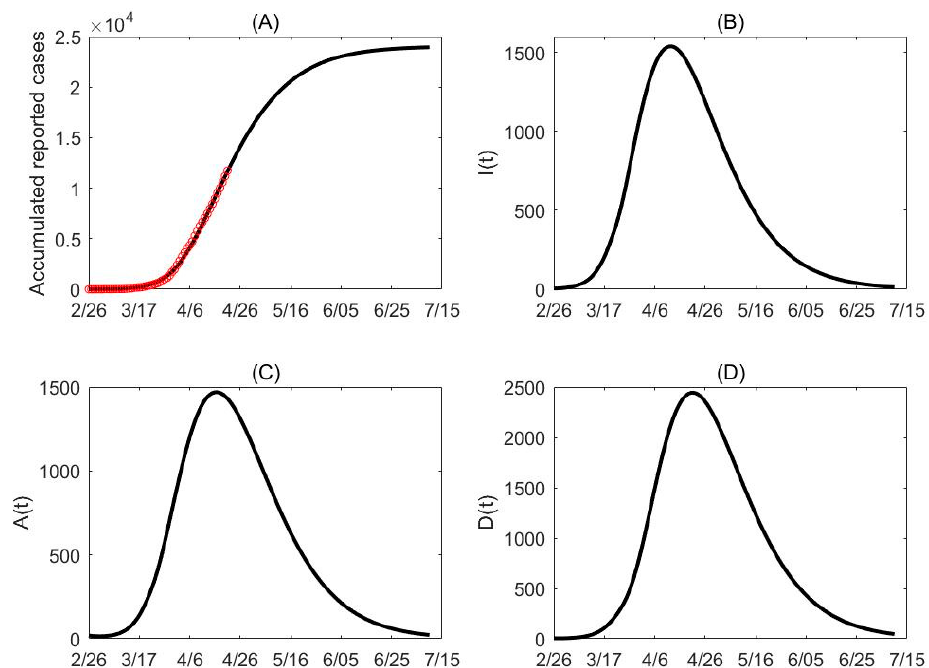
Figure 2. Data fitting and projection. ( A ) The red circles represent the cumulative confirmed cases in Ontario, Canada. ( B – D ) Based on the mean curve of the 500 times estimation, the population of I ( t ) , A ( t ) and D ( t ) reach their peak times around April 12, April 16 and April 21 while the peak values are around 1538, 1469 and 2444, respectively. The final cumulative confirmed cases projected by the model is about 23,940.